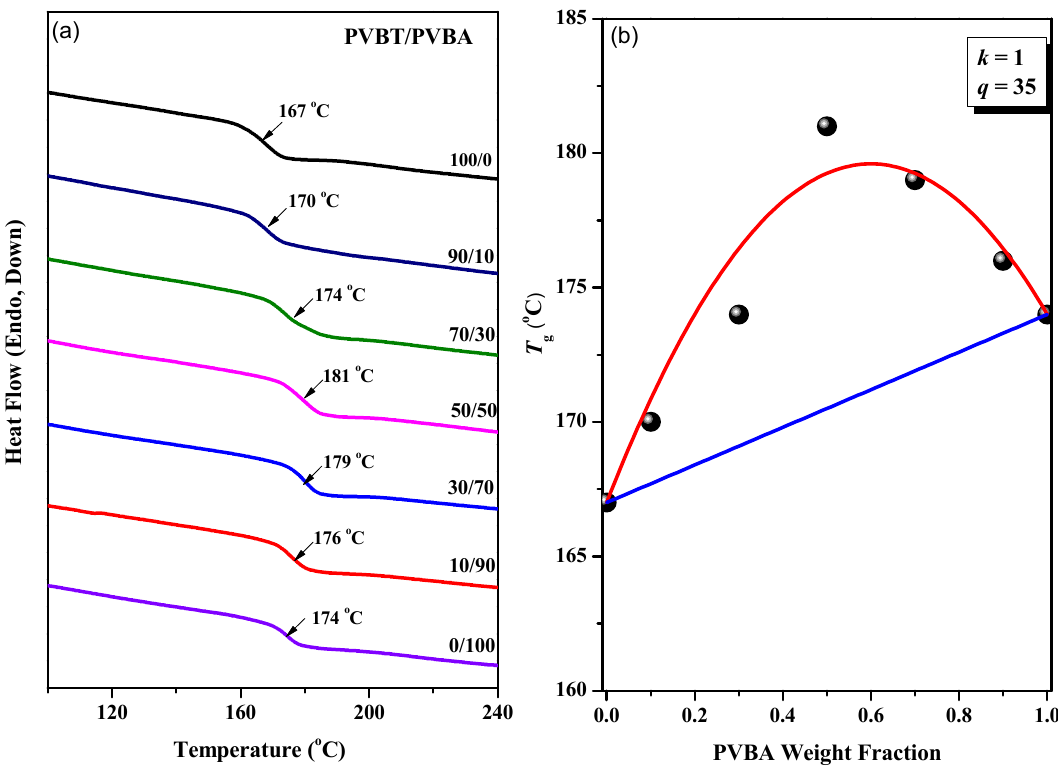
Figure 7. ( a ) DSC curves and ( b ) glass transition temperature/composition curves, based on the Kwei equation, for PVBT/PVBA blend complexes of various